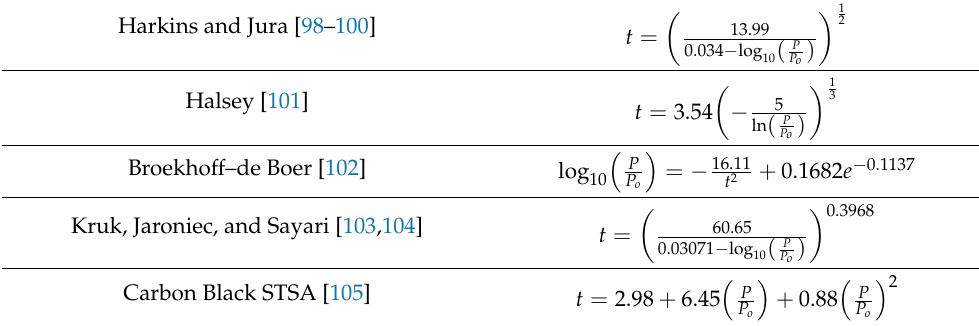
Table 2. Thickness equation commonly used for pore structure characterization.